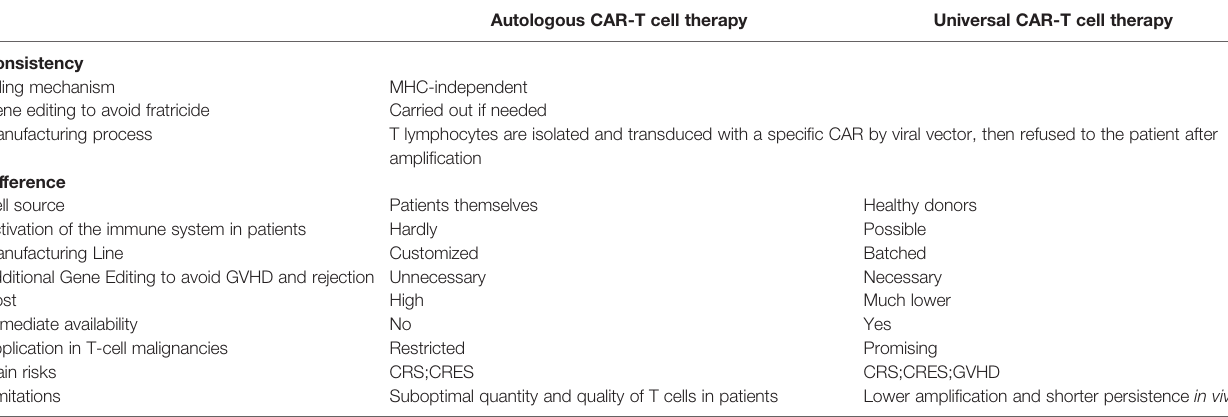
TABLE 1 | The comparison of autologous and allogeneic CAR-T cell